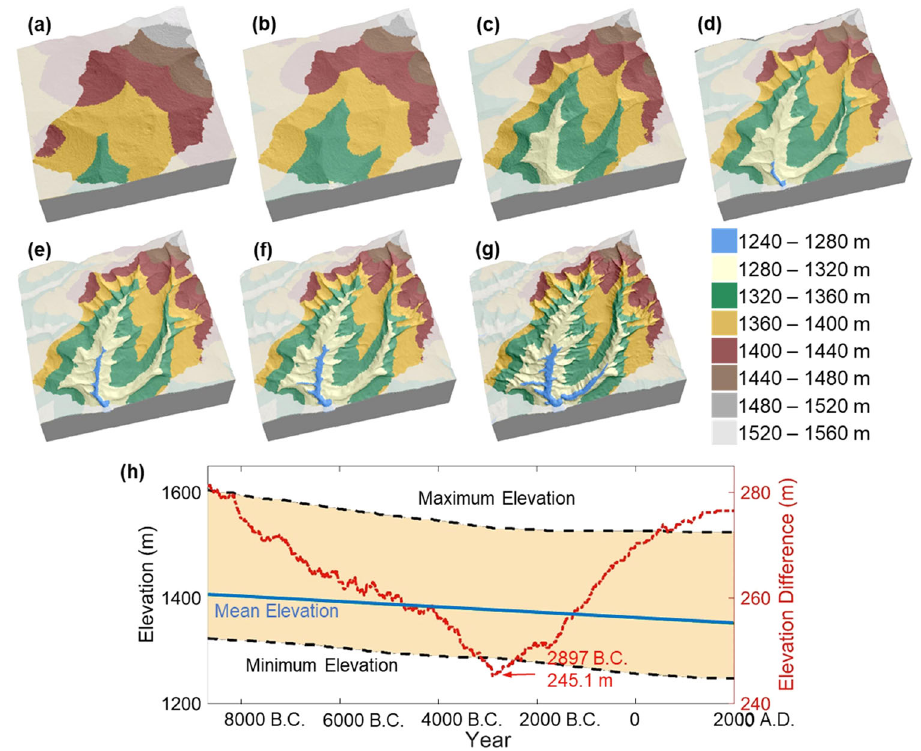
Fig. 3 Landform evolution process and the elevation statistics of the Wucheng watershed over the last 10 ka. a 8000 B.C., b 6000 B.C., c 1500 B.C. in the Shang Dynasty, d 100 B.C. in the Han Dynasty, e 700 A.D. in the Tang Dynasty, f 1300 A.D. in the Ming Dynasty, and g present. h elevation statistics. The results of factors S and L used in the landform evolution process are shown in Supplementary Fig. 6. The time calibration rule can be found in the Methods section, and the results are shown in Supplementary Table 3. The two black dotted lines and the green line represent the maximum, minimum and mean elevations of the Wucheng watershed, respectively. The red curve displays the elevation difference between the maximum and minimum elevations of the Wucheng